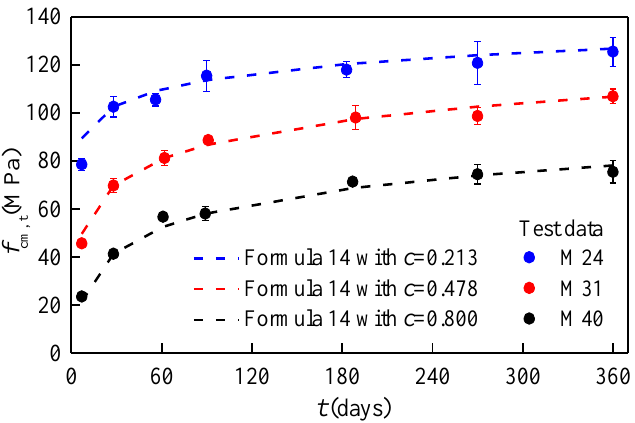
Figure 4. Comparison of calculated to test compressive strength of mortars at different curing ages. The relationship between the tensile and compressive strengths of concrete is always described by the power function, and it was not affected by the curing age [31]. Thus, the relationship of flexural strength and compressive strength of mortar is expressed as Formula (15) in this study. Where the regression coefficients of 1.491 and 0.476 are determined by the fitted test data. Figure 5 presents the comparison of the fitted curve with test data.